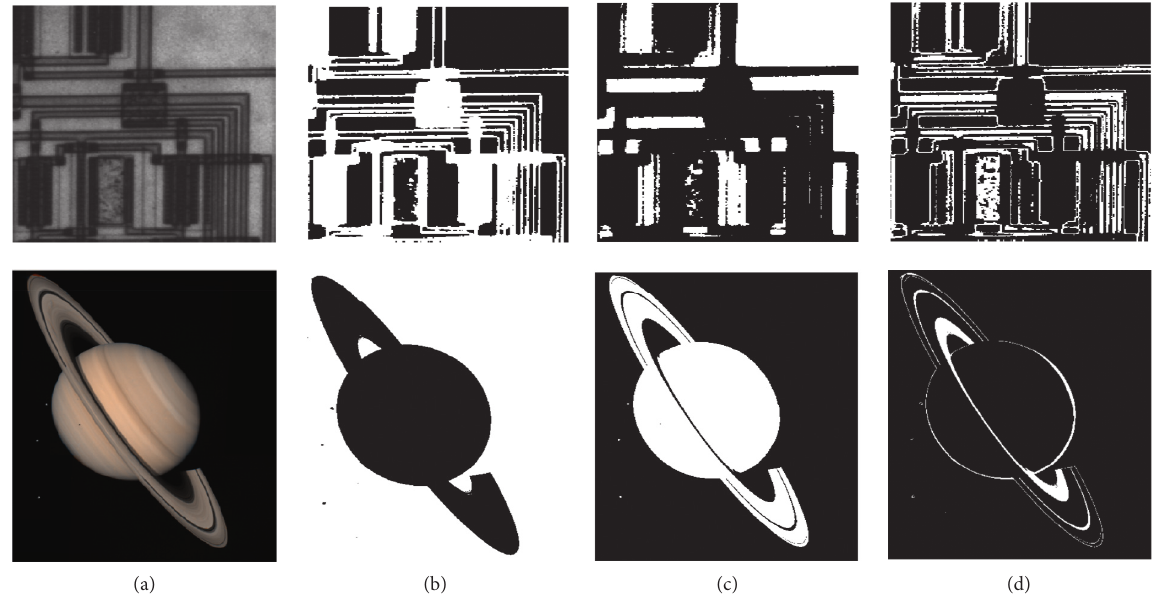
Figure 6: Examples of bilevel thresholding with three clusters. (a) Original. (b) C